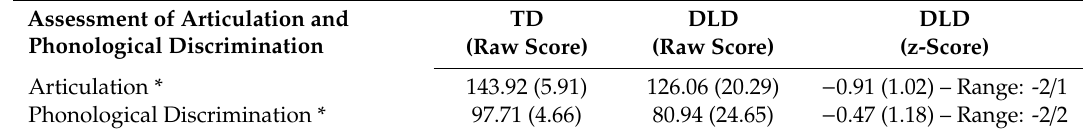
Table 4. Results (means and SDs) of the assessment of articulation and phonological discrimination skills in the two groups of participants. For children with DLDs, both raw scores and z-scores with respect to normative data are reported in separate columns. For z-scores, ranges are also reported. The asterisk (*) shows when the group-related di ff erence in raw scores is significant.